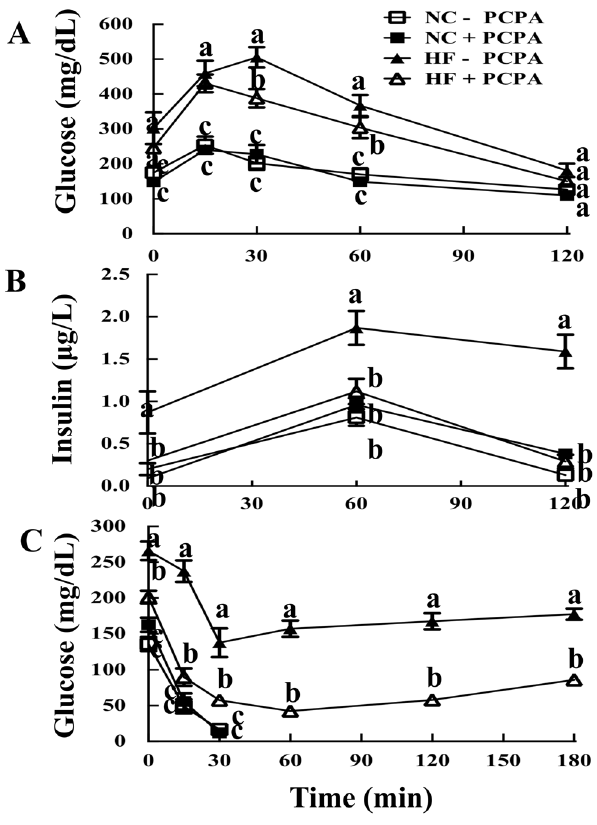
Figure 3. Mice treated with 2-PCPA are more glucose and insulin tolerant. Mice fed a HFD with or without 2-PCPA for 90 days were fasted for five hours and 1 g glucose/kg lean mass was injected intraperitoneally. Blood was drawn at different time points for measurements of plasma glucose (A) and insulin (B). (C) To determine tolerance to insulin, mice were fasted for four hours and injected intraperitoneally with 1 U insulin/kg lean mass. Glucose was measured at different time points. Lines represent means 6 standard errors of each group (n=5). Statistical analysis was performed using a two-way ANOVA followed by the Student-Newman-Keuls multiple range test. Identical letters indicate data points that are not statistically different from each other (p ,